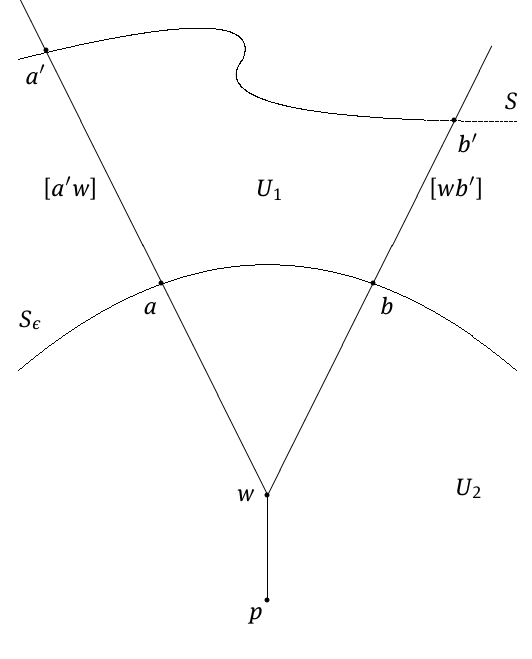
Figure 1: Proving S ϵ is a